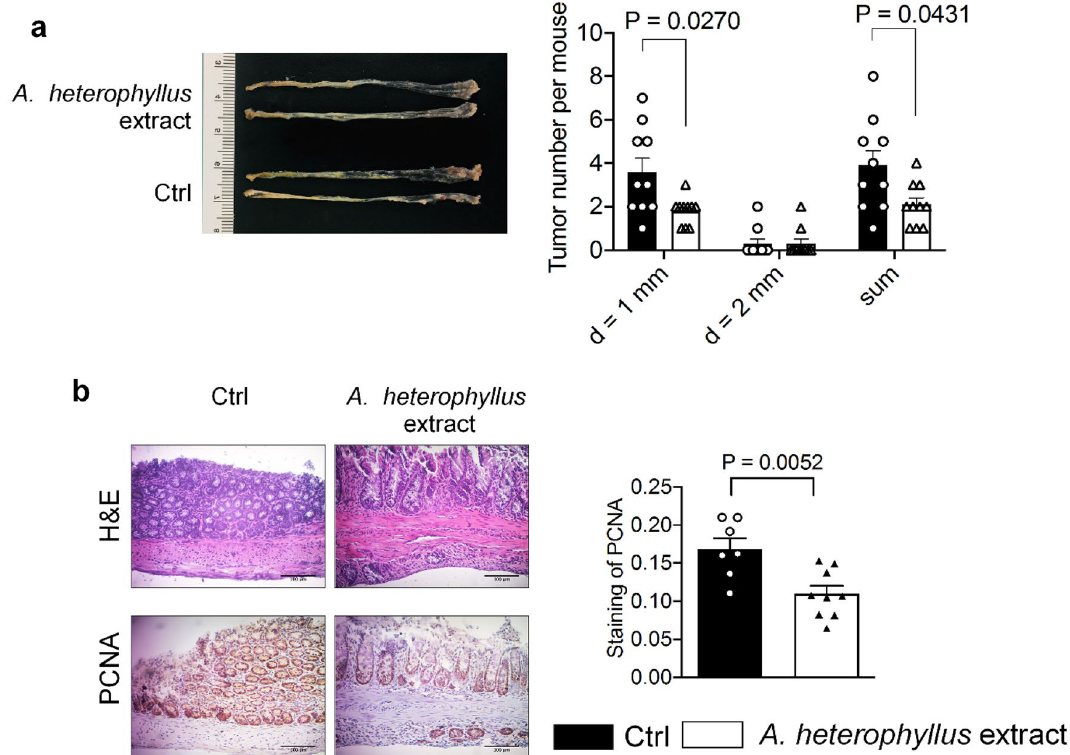
Figure 5. The Artocarpus heterophyllus extract suppresses AOM/DSS-induced colon tumorigenesis in mice. ( a ) Quantification of colon tumorigenesis in mice. Dissected colons were examined for number and dimension of tumors in each group and categorized on the basis of diameter (approximately 1 mm, 2 mm, and total sum). ( b ) H&E staining and immunochemical staining of PCNA in the colon scale bar=100μm. The results are expressed as the mean ± SEM, n = 11 mice in Ctrl group and n = 10 mice in the A. heterophyllus group. Ctrl, vehicle control; d,